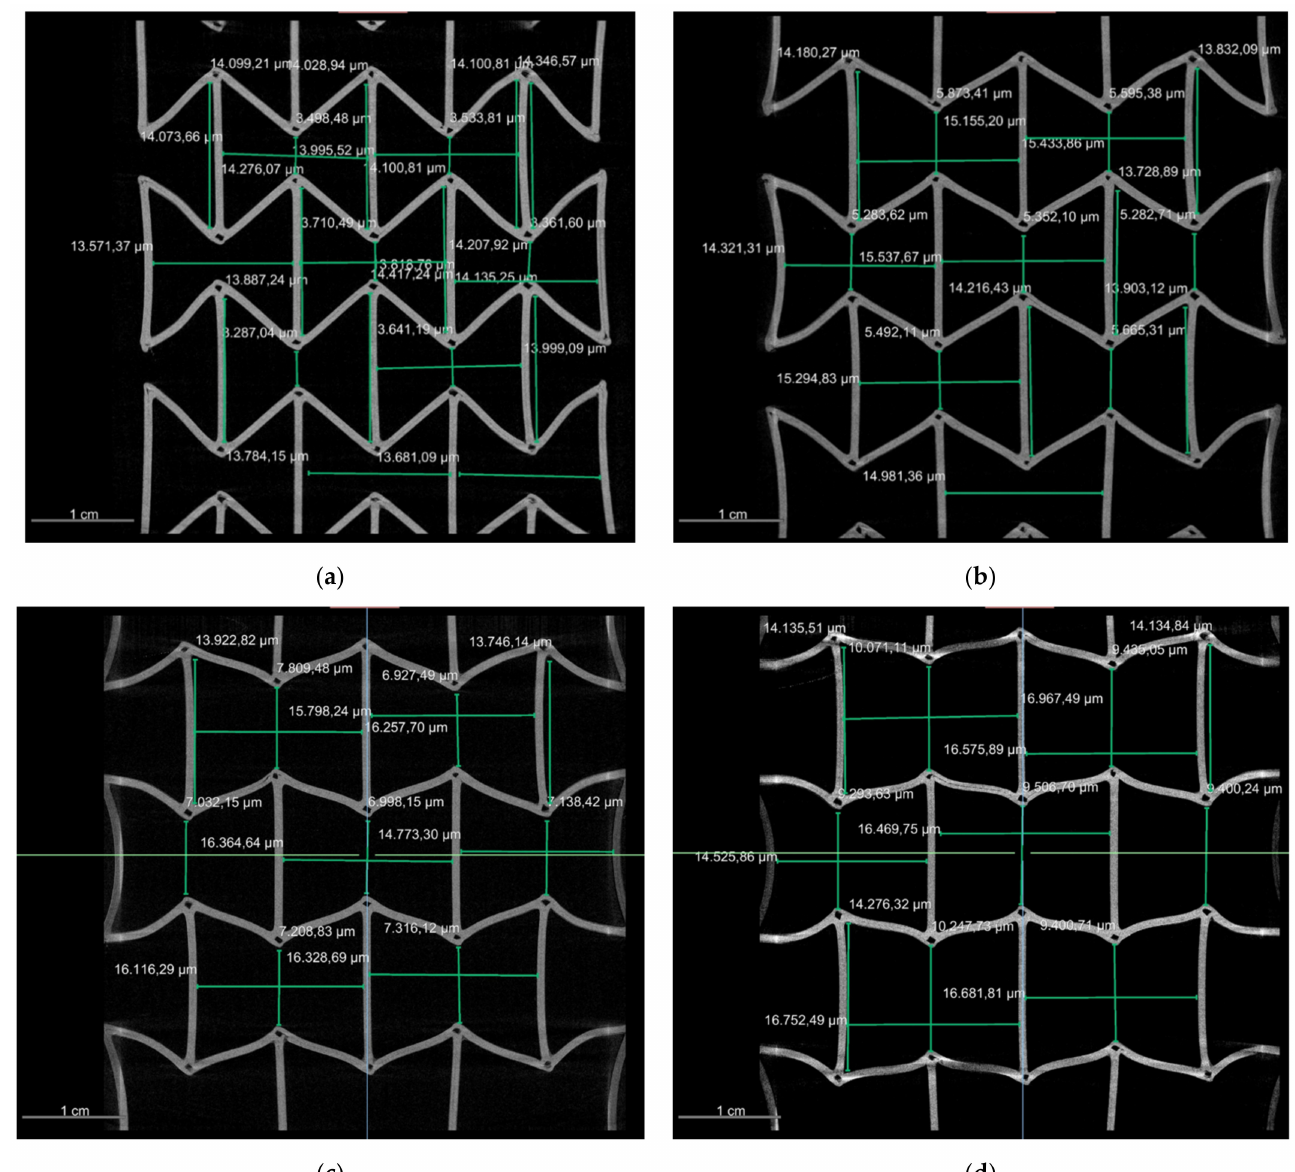
Figure 21. Measured wall length, wending points’ distance in individual honeycomb in a 3 × 3 PBAT sample at ( a ) 0 mm, ( b ) 5 mm, ( c ) 10 mm, and ( d ) 15 mm loading